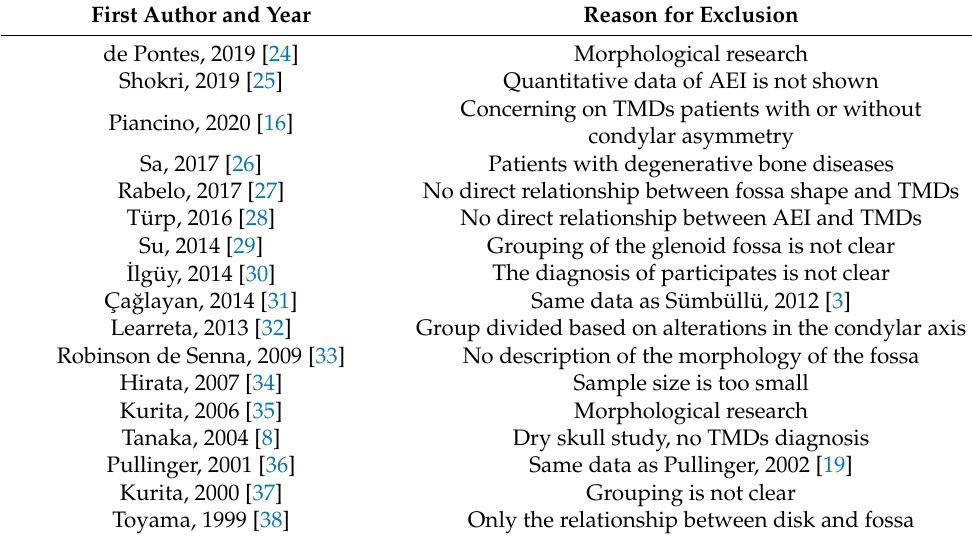
Table 2. Studies retrieved in full text and excluded from the